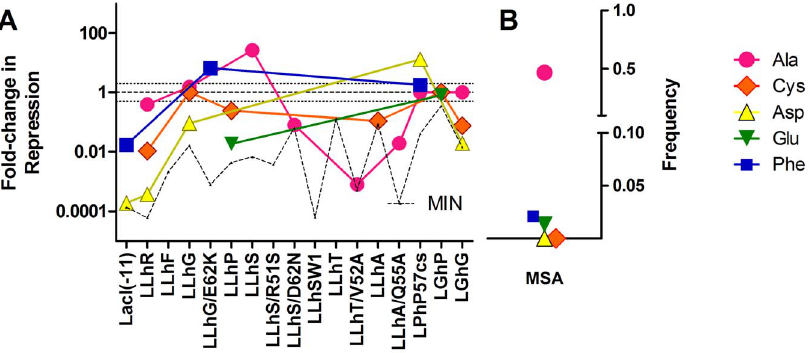
Figure 2. Substitution outcomes do not correlate with amino acid frequency. (A) Substitution outcomes for position 51 among the LacI/ GalR chimeras; 5 amino acid substitutions are shown. Each starting protein had different repression activity, which was used to normalize its variants. No change corresponds to a value of 1 (dashed black line). The straight dotted lines indicate 2-fold change from the starting protein; this range is usually larger than the error bars of a repression measurement. Substitutions that enhance repression have increased fold-change ( . 2). Substitutions that diminish repression have decreased fold-change ( , 2). The jagged dotted line shows the no repressor ‘‘DEL’’ control relative to the starting protein and represents the lowest possible value. Colored connecting lines are to aid visual inspection of the data. (B) Amino acid frequency in the naturally occurring proteins at position 51, as calculated from the MSA of LacI/GalR proteins with a ‘‘YPAL’’ motif. Even though Ala occurs with high frequency, this substitution can be catastrophic. Further, even though Asp is absent from the natural sequences, this substitution can enhance repression in at least one chimera.